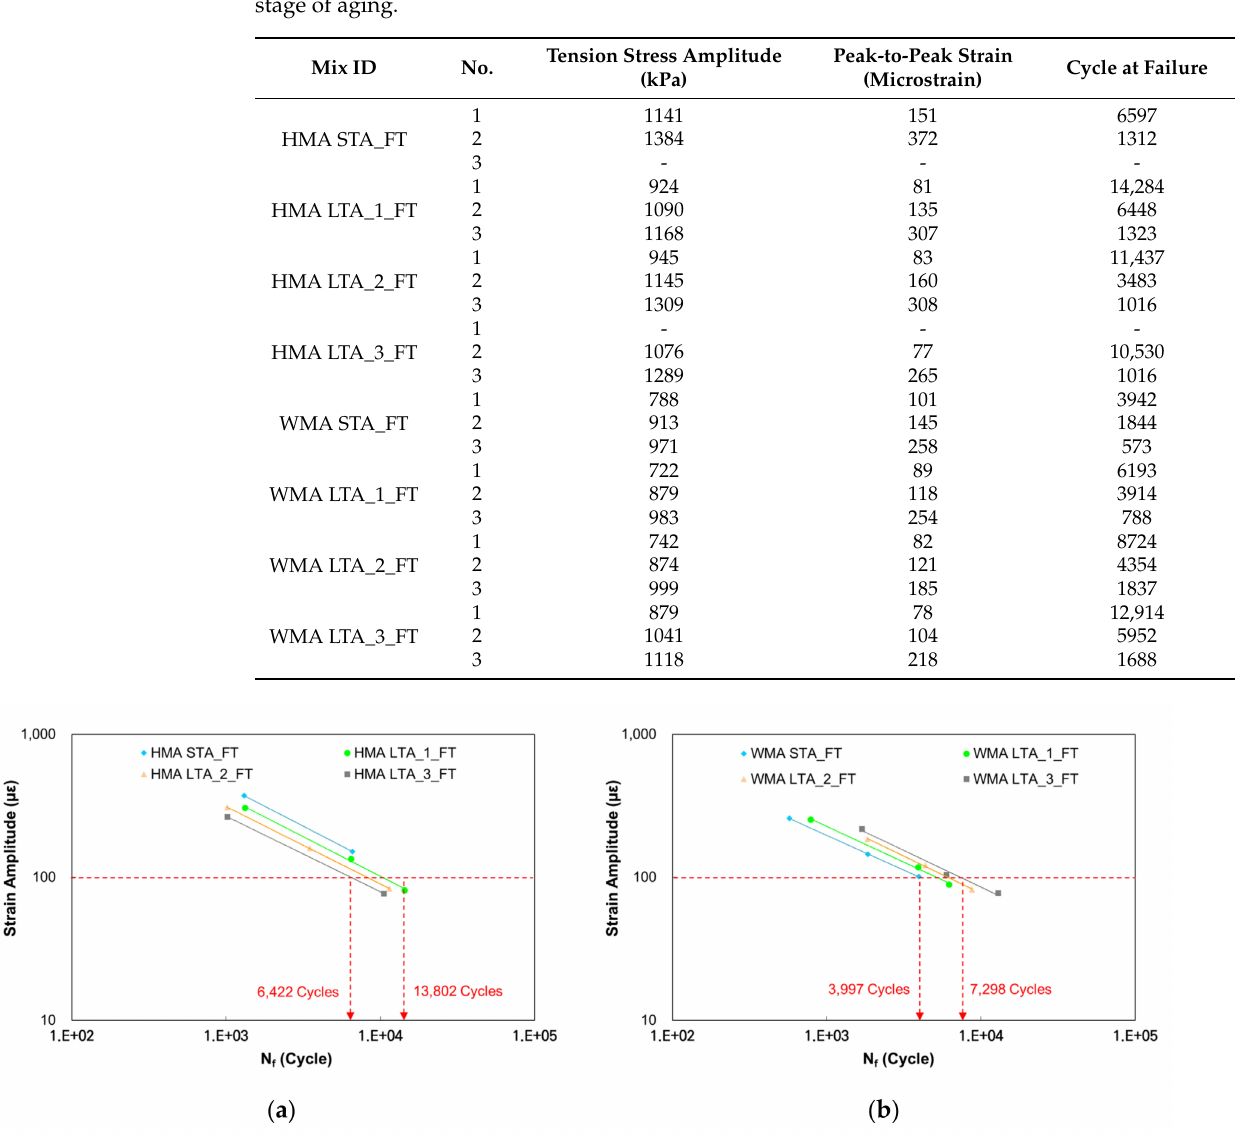
Figure 15. Allowable fatigue cracking cycles after moisture damage for each stage of aging: ( a ) HMA and ( b )